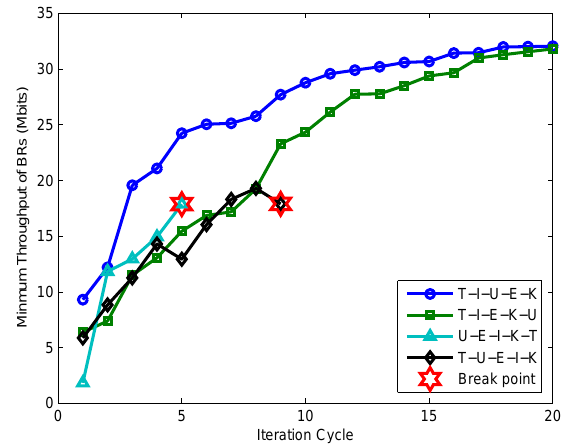
Figure 10. Convergence performance comparison of different optimization orders for the case B k [ 0 ] > 0, T = 240 s .